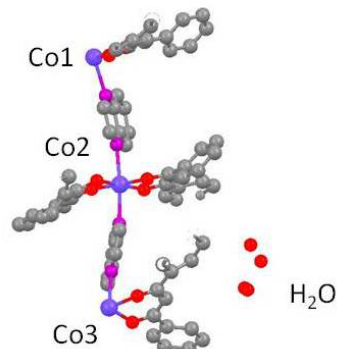
Figure 2. Ball-and-stick model of trans -[Co(DBM) asymmetric unit. Co1 and Co3 are located at i symmetry positions, i.e. , nodes, on the wavelike polymer chain. The disordered interstitial water molecules have occupancies of 0.5. The hydrogen atoms are not included for clarity (C, gray; Co, blue; N, purple; O, red).